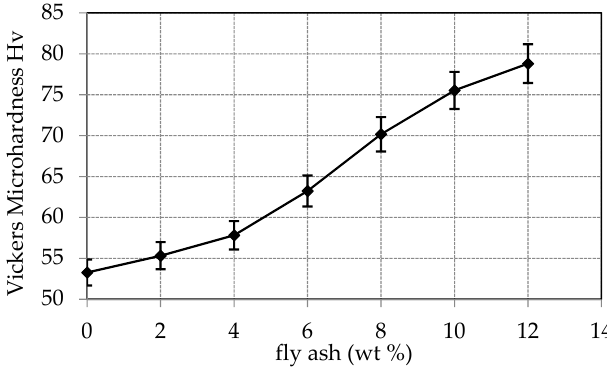
Figure 10. Vickers microhardness of AA6063 ‐ FA composites as a function of fly ash percentage content.